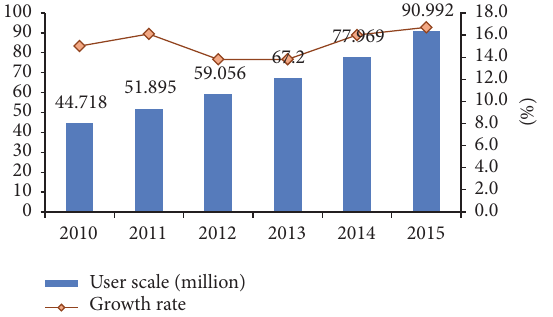
Figure 1: 2010–2015 E-Learning user scale.